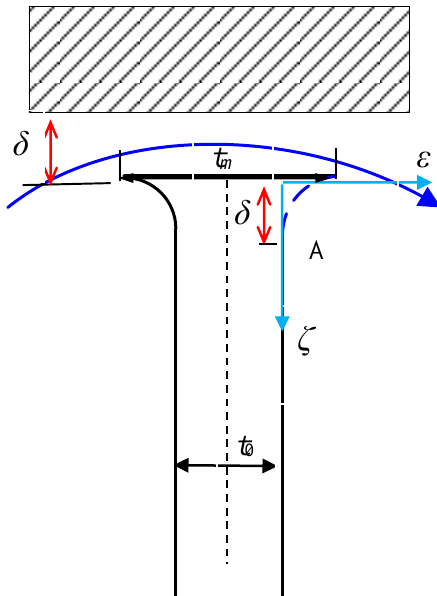
Figure 2. Sketch map of T-shape tip.